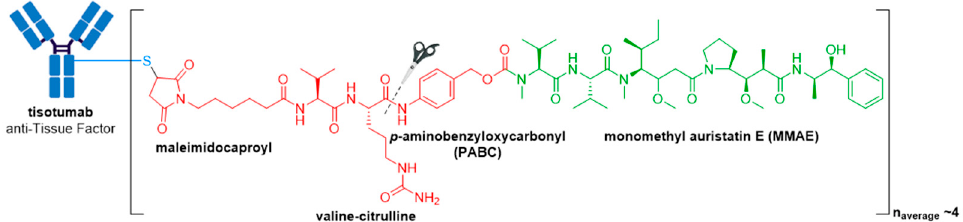
Figure 16. Structure of Tivdak ® (tisotumab vedotin-tftv). The antibody is shown in blue, and chemical structures for linker and payload are in red and green, respectively.